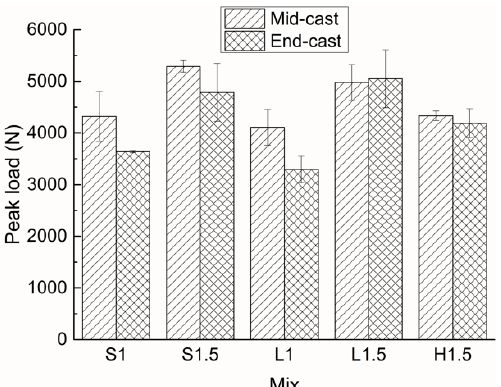
Figure 6. Peak loads of all the UHPCs with two different casting positions.